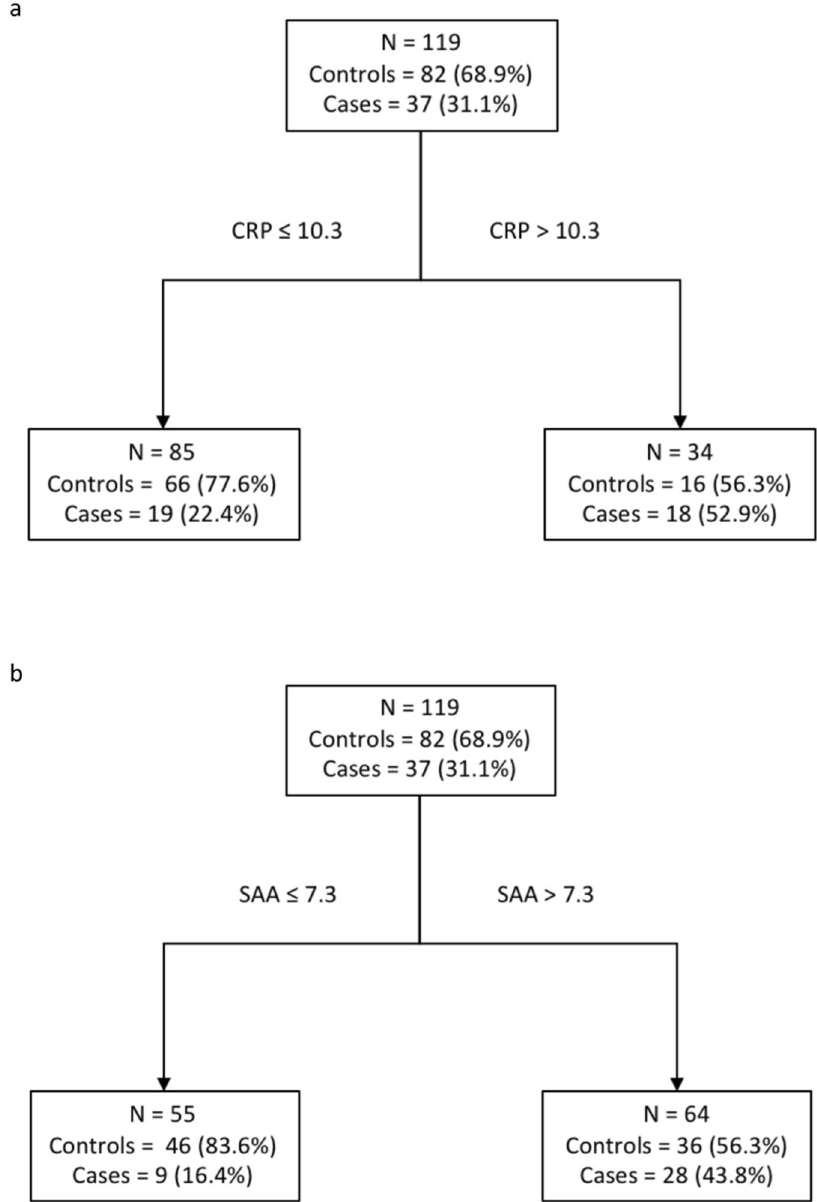
Fig. 3 Classi fi cation trees (HER2 − subjects). a CRP; b SAA.